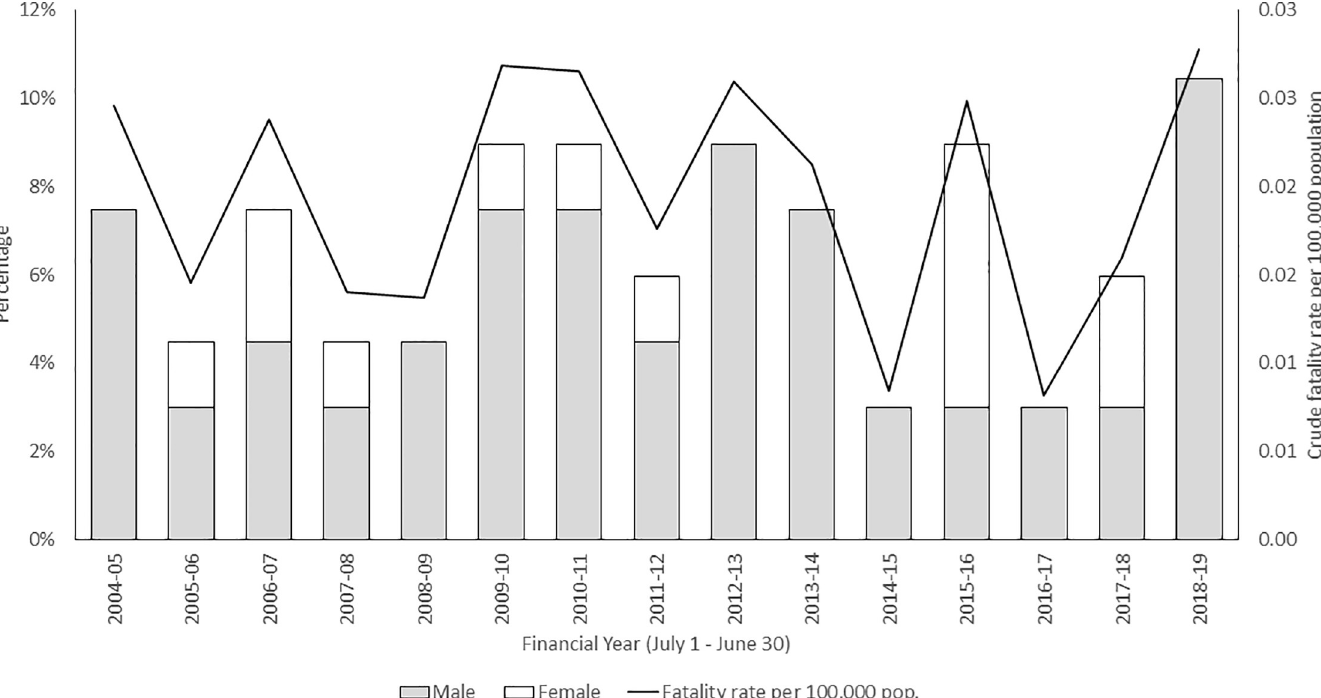
Fig 1. Annual percentage of coastal fatal bystander rescues in Australia by gender per financial year (July 1 to June 30) with crude fatality rate per 100,000 population between 1 st July 2004 and 30 th June 2019.